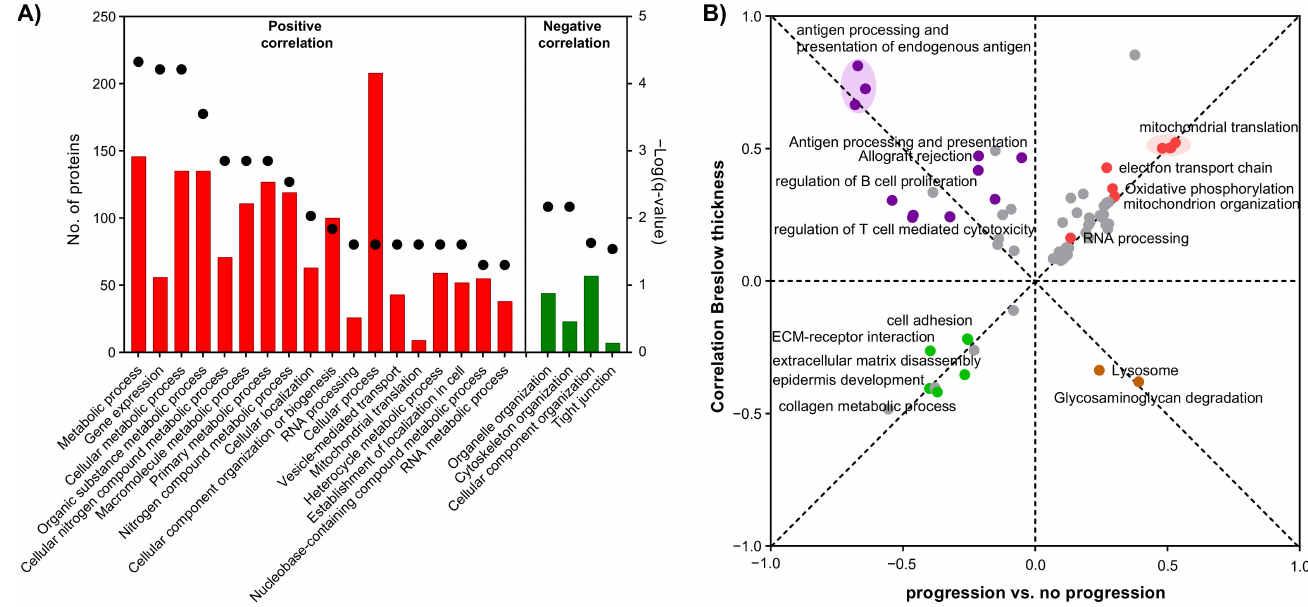
Figure 5. Functional biological annotations associated with the Breslow thickness of primary melanomas. ( A ) Functional enrichment analysis of the proteins with a significant correlation to the Breslow thickness of the tumors. ( B ) 2D functional enrichment analysis between the correlation at the proteome level with Breslow thickness of the tumors and the progression status of the patients. Highlighted in red are relevant annotations up-regulated in the progression group and with positive correlation with the Breslow thickness; in green, annotations down-regulated in the progression group and with negative correlation with Breslow thickness; in purple and brown are annotations oppositely correlate with progression and Breslow